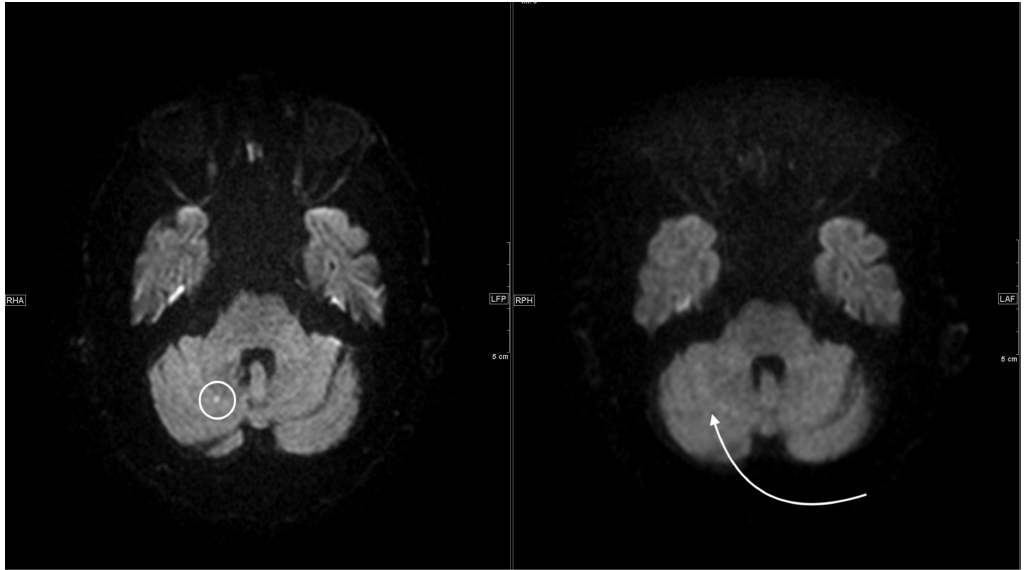
Figure 6. Left side, axial 1.5 T DWI sequence with sharply hyperintense delineable, punctiform DWI lesion located cerebellar right. On the right side, corresponding 0.55 T axial DWI sequence with the same slice localization without sufficiently detectable lesion.